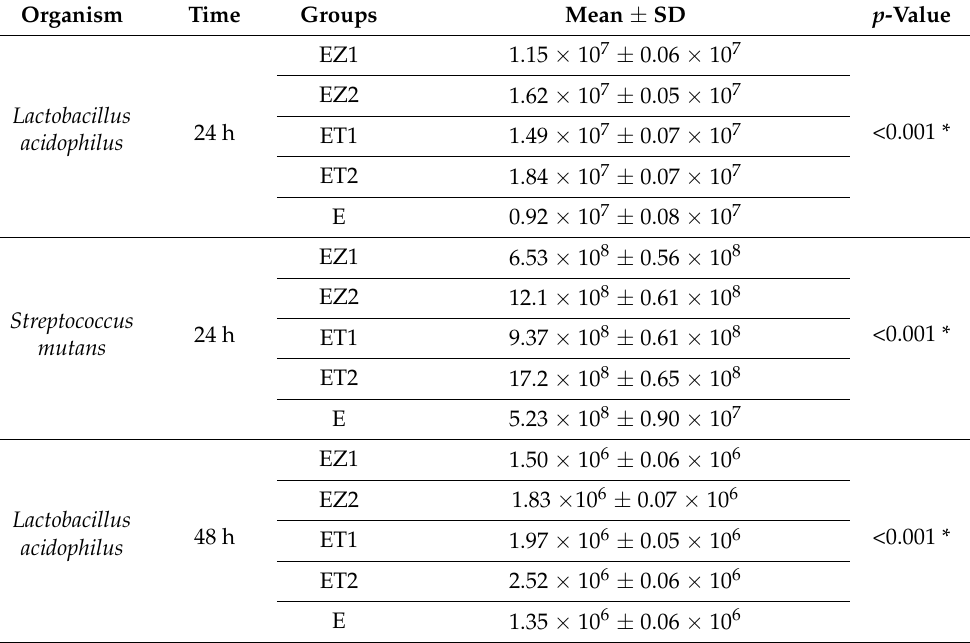
Table 2. Mean number of colonies (CFUs) of Lactobacillus acidophilus and Streptococcus mutans at 620 nm by ELISA at 24 h, 48 h, and 72